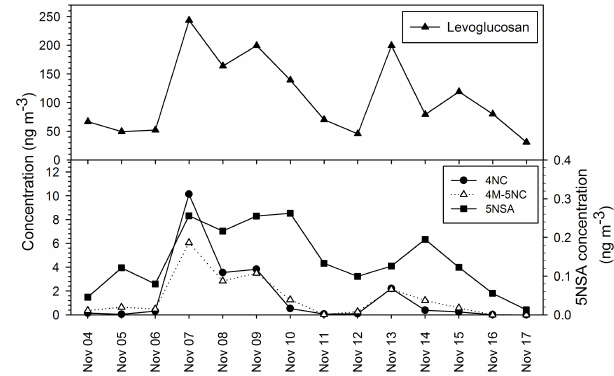
Figure 5. Time series of ambient PM 2 . 5 concentration of lev- oglucosan, 4-nitrocatechol (4-NC), 4-methyl-5-nitrocatechol (4-M- 5NC), and 5-nitrosalicylic acid